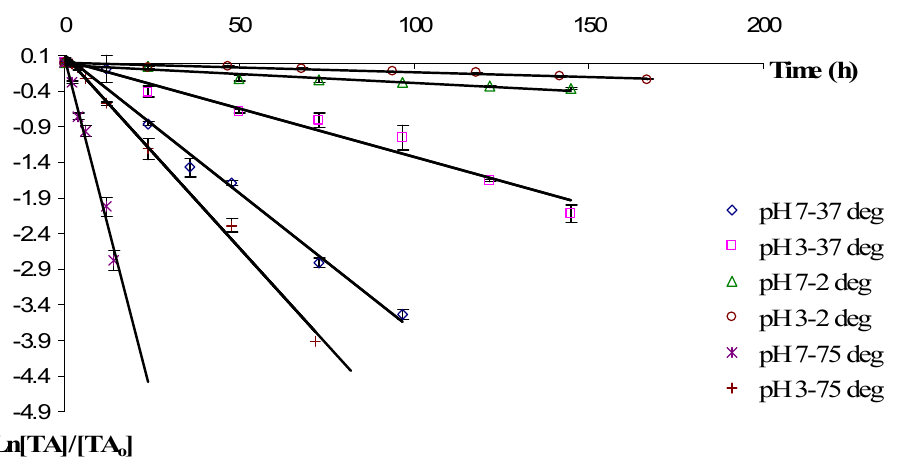
Figure 2. Degradation of anthocyanins in cranberrybush fruits ethanolic extract during storage at different temperature and pH values (Vertical lines represent SD, n =